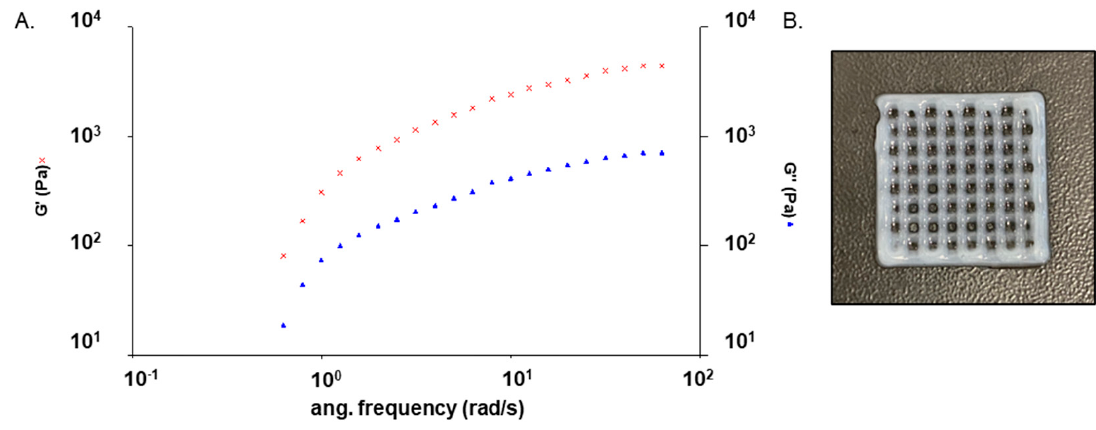
Figure 2. ( A ) Variation of the elastic (G’, red crosses) and viscous modulus (G”, blue triangles) with frequency of GEL–ALG ink. ( B ) GEL–ALG scaffold photograph after printing.